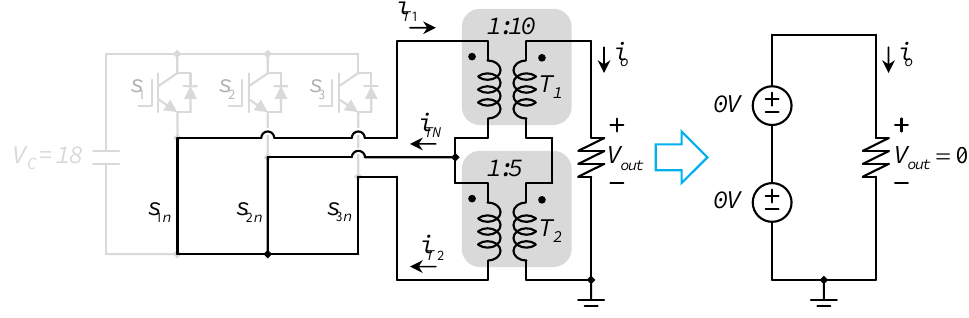
Figure 4. Equivalent circuit when s 1 = 0, s 2 = 0, and s 3 = 0 ( s 1 n = 1, s 2 n = 1, and s 3 n = 1).